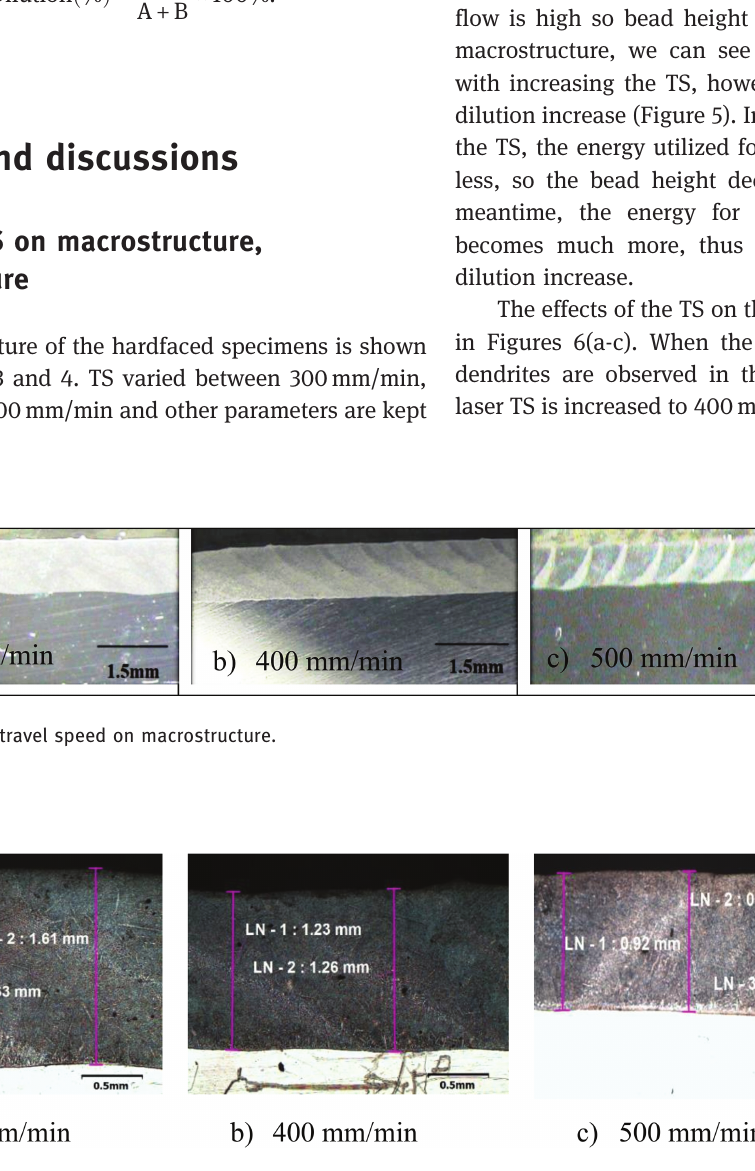
Figure 4: Effect of travel speed on deposit thicknesses.